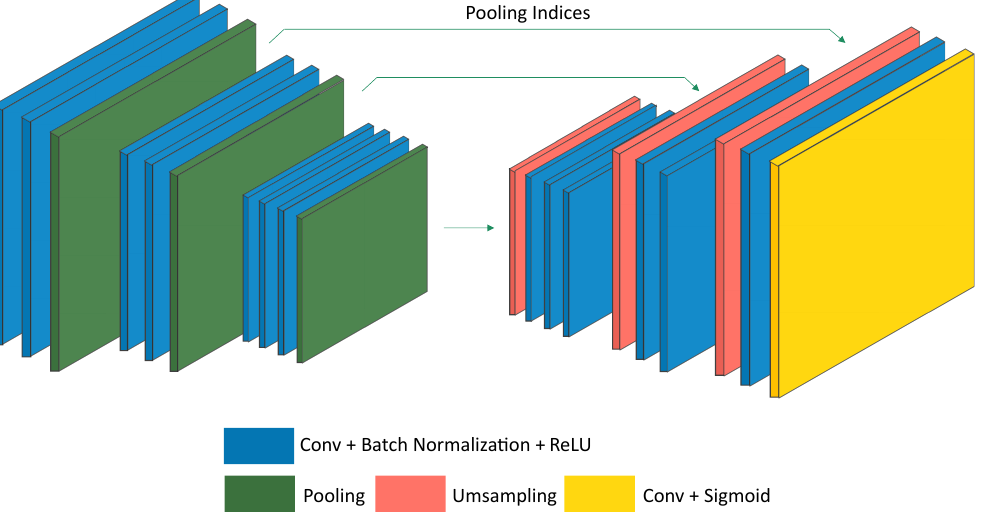
Figure 7. SegNet architecture adapted from a figure in [9], which is licensed under CC BY